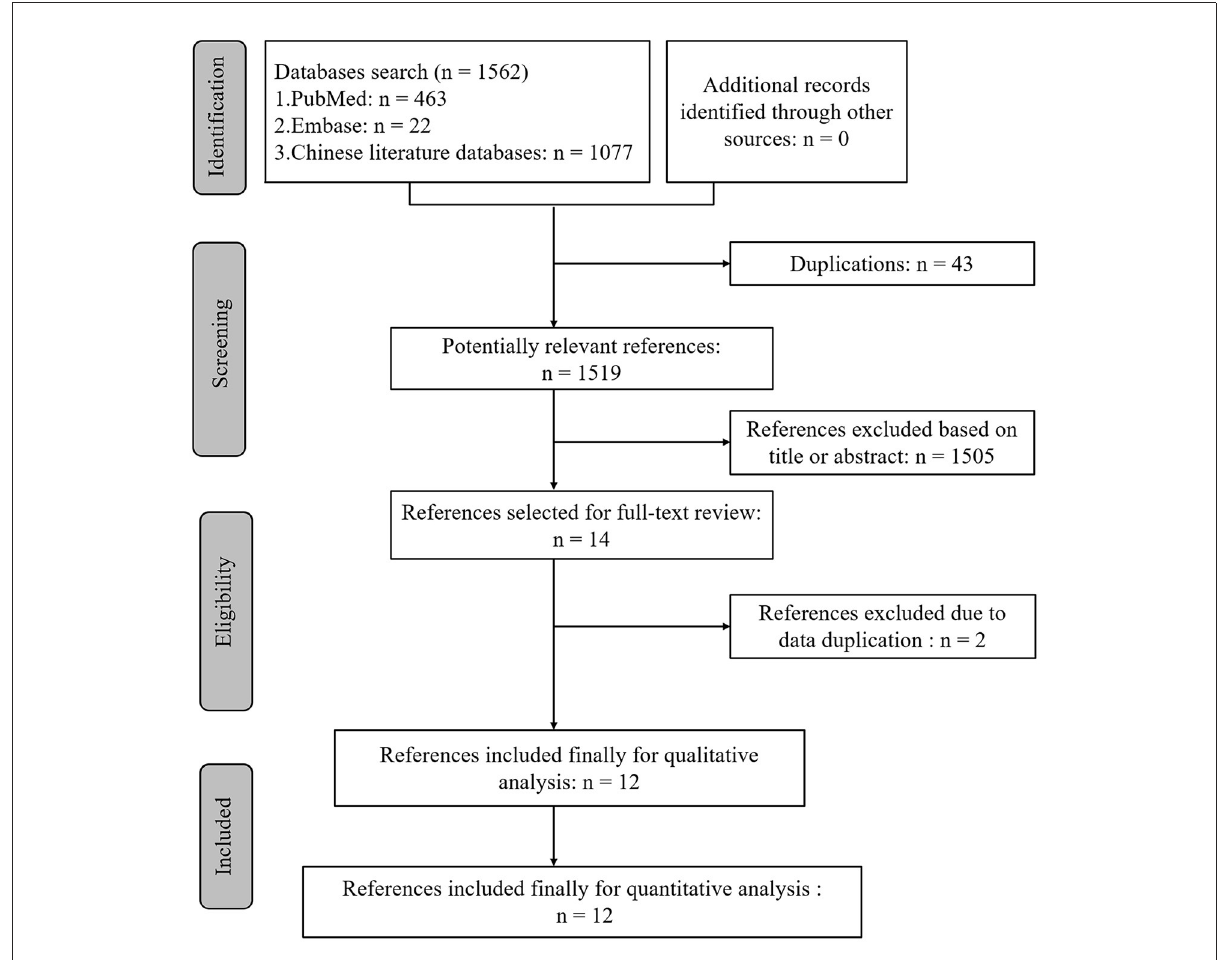
FIGURE1 Summary of the literature identification and selection